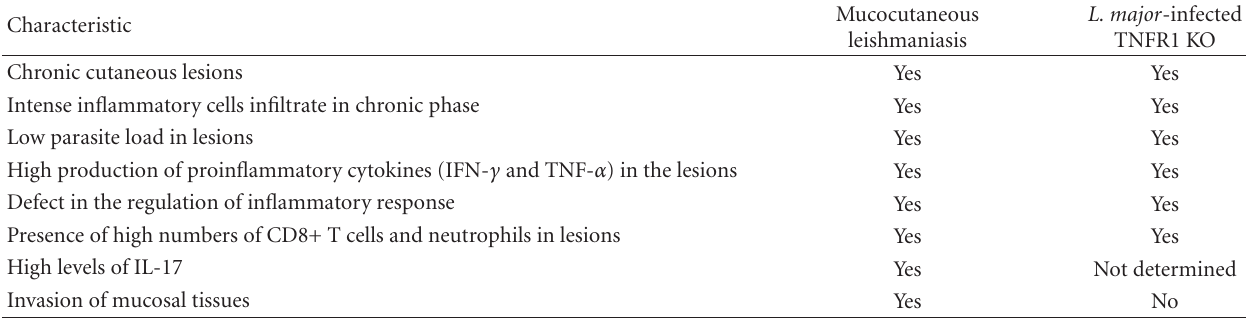
Table 3: Comparison between human mucocutaneous and TNFR1 KO